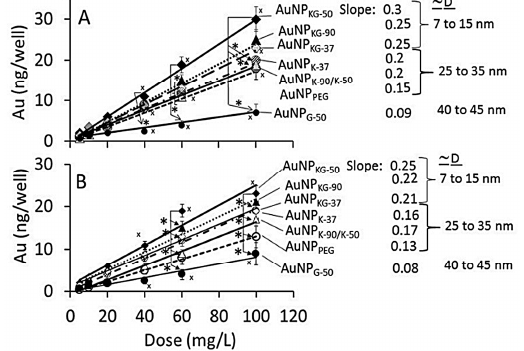
Figure 5. The dose (mg/L of AuNPs) versus response (intracellular Au concentration—iAuC) curves for internalization of different AuNPs at day 16 of cell incubation. ( A ) Ap/En cells, and ( B ) Ap/Ep cells. Values are mean ± SD. *: p < 0.05, significant, when compared with corresponding data from different groups, x: p < 0.05, significant, when compared with different dose values from the same group.